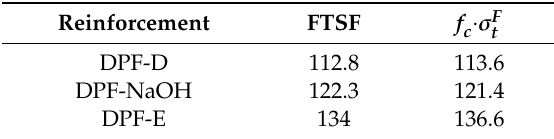
Table 4. FTSF compared to micromechanical results.